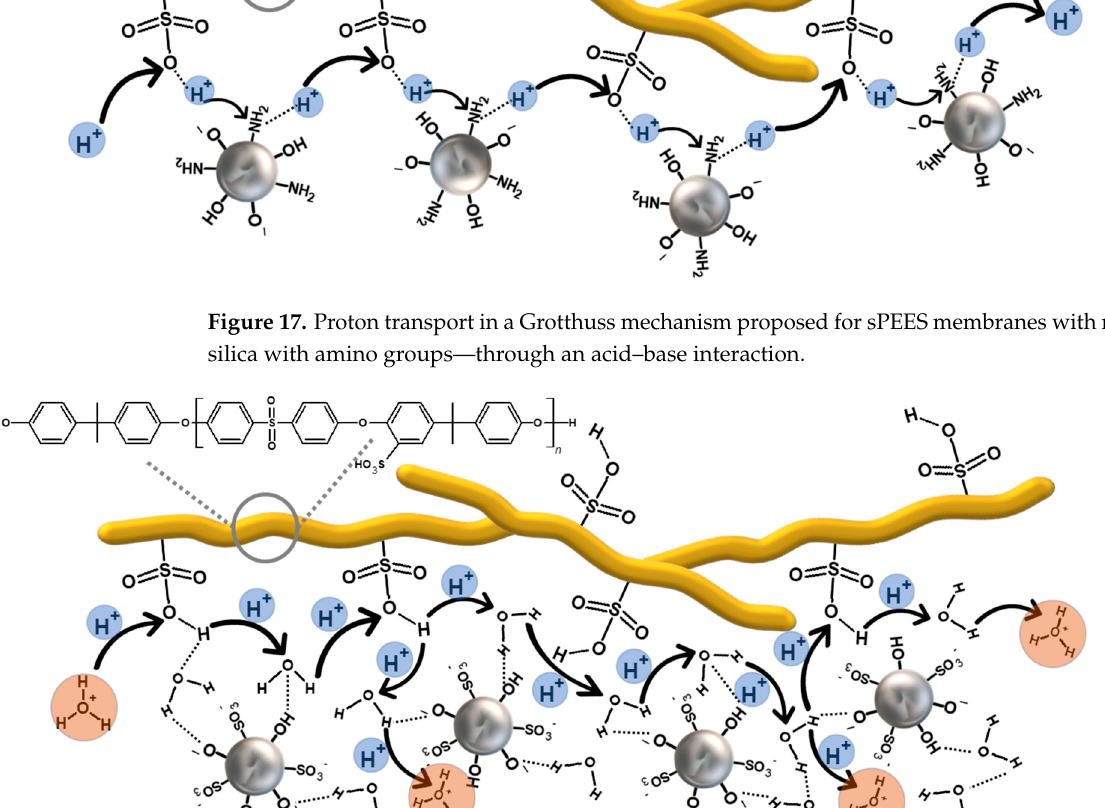
Figure 17. Proton transport in a Grotthuss mechanism proposed for sPEES membranes with modi- fied silica with amino groups—through an acid–base interaction.